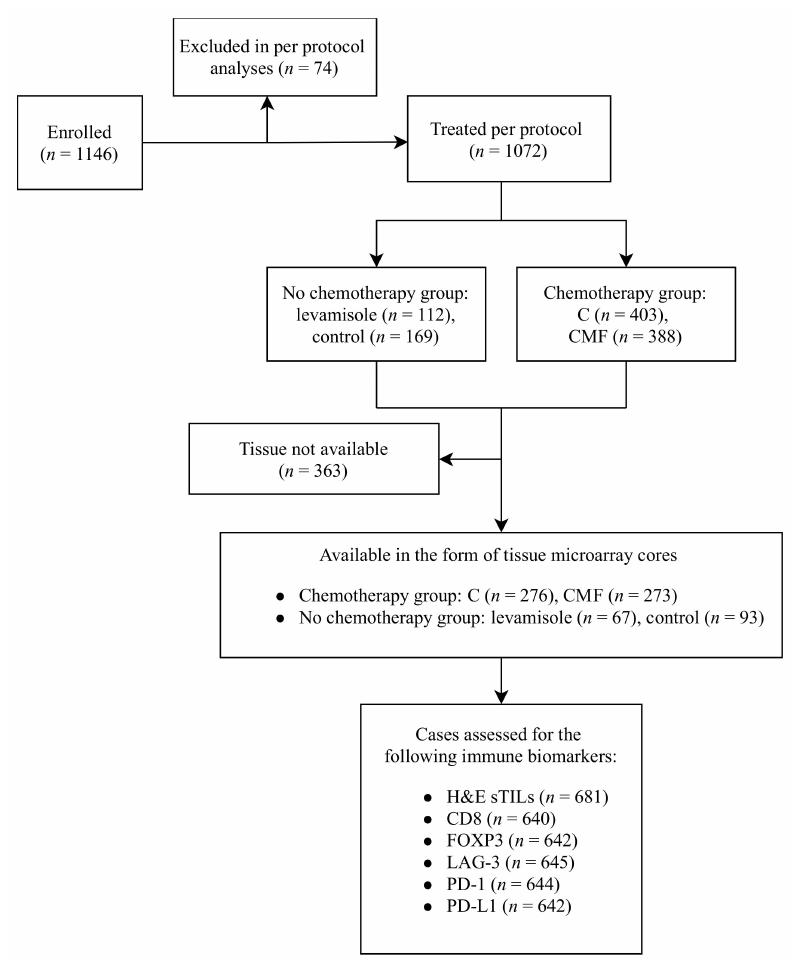
Figure 1. CONSORT diagram of DBCG77B phase III clinical trial immune biomarker